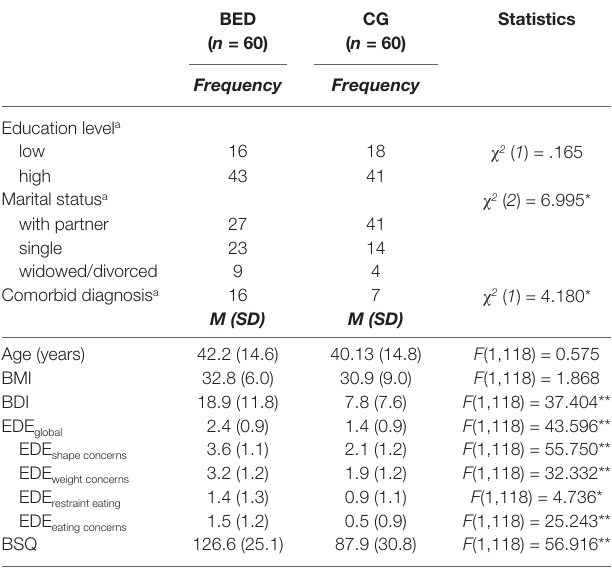
TABlE 1 | Descriptive characteristics of demographic and psychopathological variables for women with binge eating disorder (BED) and women with overweight and obesity